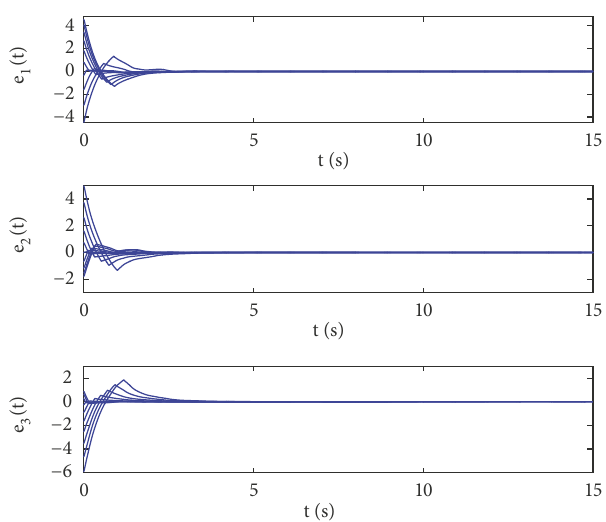
Figure 9: Select 10 random initial conditions and state trajectories of the synchronization errors 𝑒 1 (𝑡) , 𝑒 2 (𝑡) , and 𝑒 3 (𝑡) with 𝜉 = −2